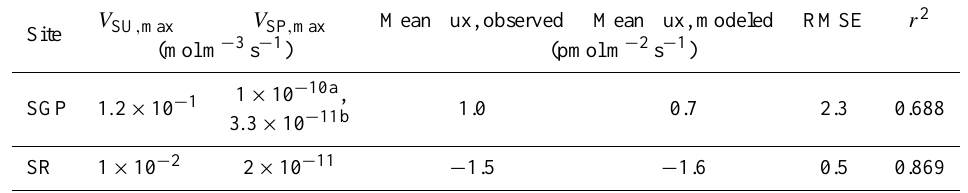
Table 3. Summary of model evaluation